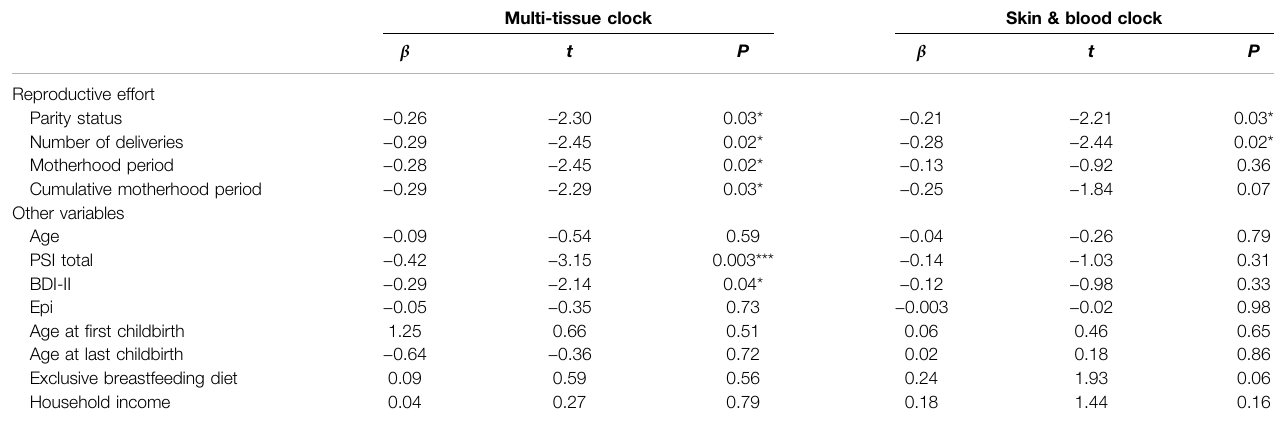
TABLE 2 | Simple linear regression with robust standard errors for mAge accelerations. Multi-tissue clock Skin & blood clock